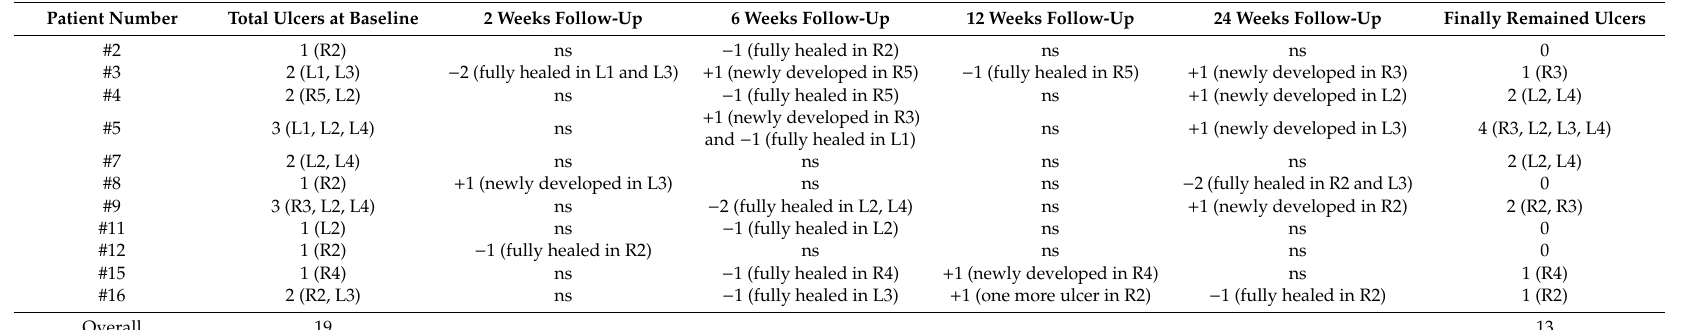
Table 7. Clinical progress of digital ulcers in enrolled